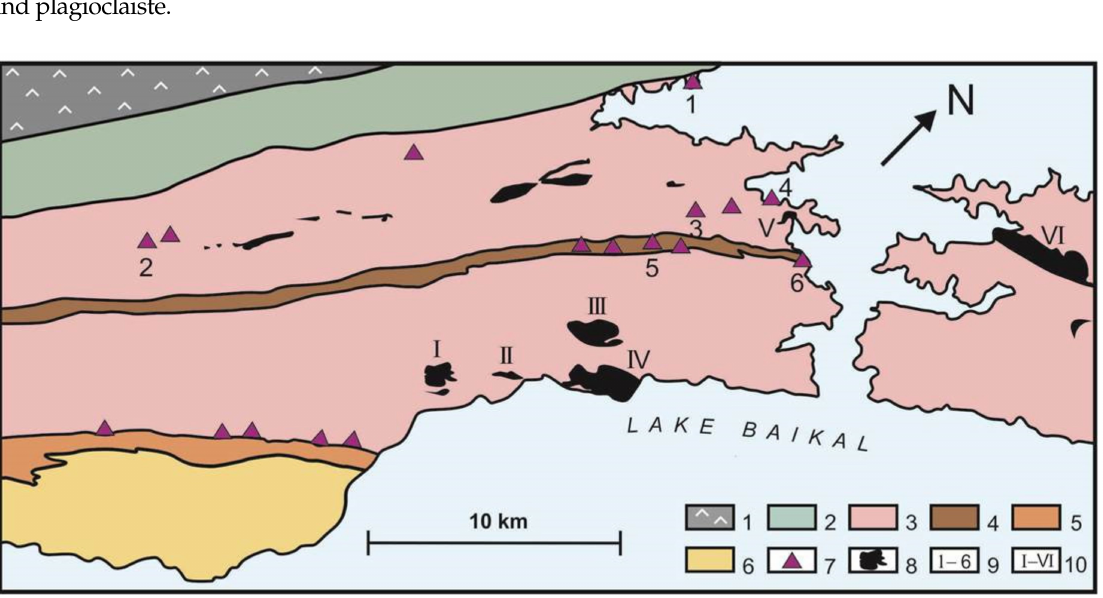
Figure 2. Ophiolitic ultramafics and gabbro in the northeastern Olkhon area. 1 = Paleoproterozoic igneous and metamorphic complexes of the Siberian craton. 2–8 = igneous and metamorphic complexes of the Olkhon terrane: marbles, gneisses, and mafic granulites (2); a complex of predominant gneissic granites and less abundant amphibolites, marbles, and quartzites (3); main strike-slip zone composed of amphibolites (4); Orso microterrane between the Krestovsky island arc subterrane and a collage of microterranes (5); island arc carbonate-amphibolite rocks of the Krestovsky subterrane with large gabbro bodies (6); small peridotite bodies (7); gabbro (8). Arabic numerals stand for names of peridotite bodies: Shida (1), Turpan (2); Bezymyanny (3); Bayar (4); Tog (5); Sakhyurta (6). Roman numerals stand for names of gabbro bodies: Orgoita (I); Treugolnik (II), Tankhan (III); Gantel (IV); Krest (V); Olkhon